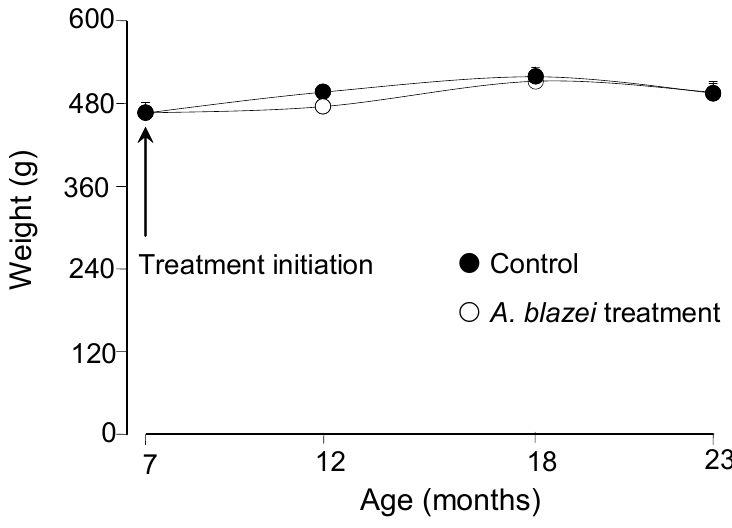
Figure 1. Body weight as a function of age of control and A. blazei -treated